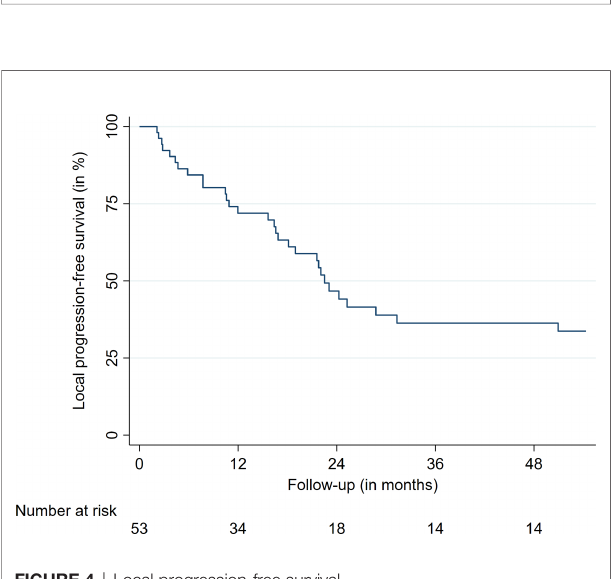
FIGURE 3 | Overall local control.